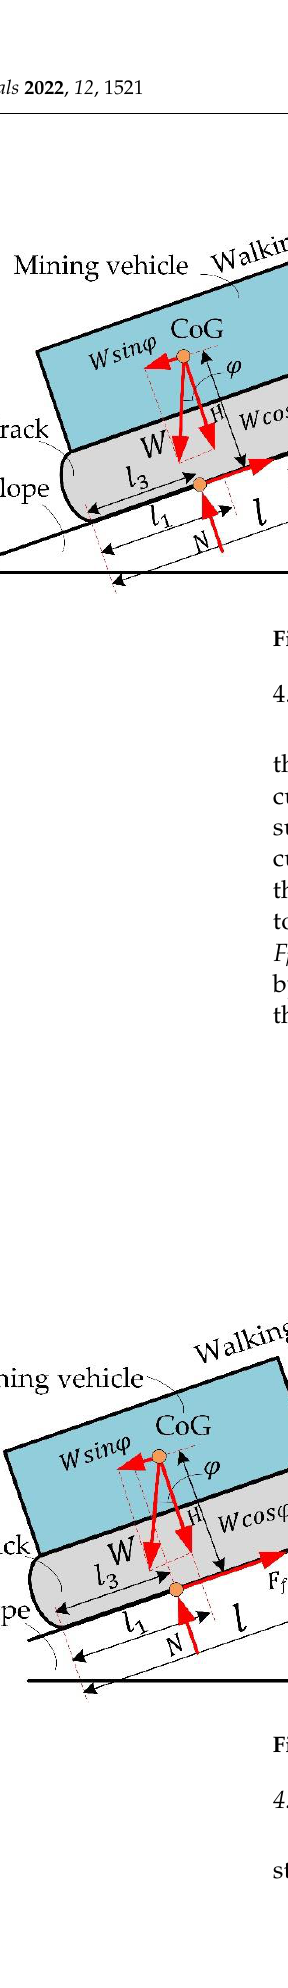
14 of 28 Figure 5. Slope stability diagram of mining vehicle with down-milling cutting head. 2